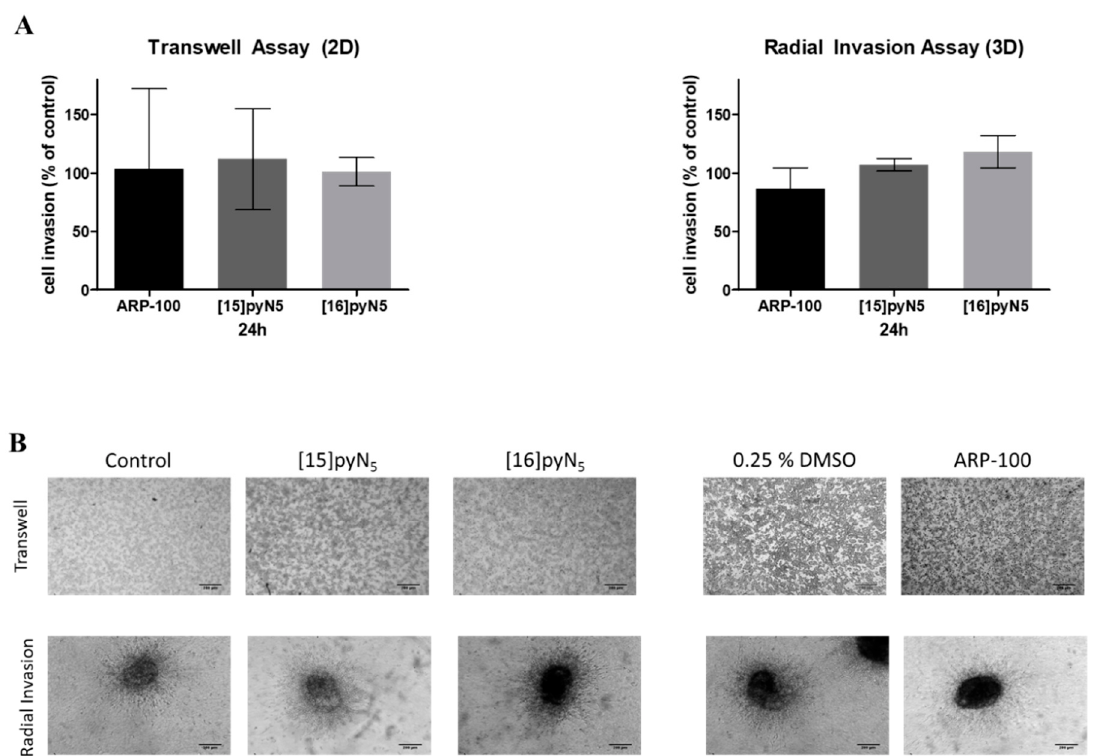
Figure 9. E ff ect of [15]pyN 5 , [16]pyN 5 and ARP-100 in cell invasion in 2D (Matrigel TM coated transwells) and 3D (radial invasion) models. ( A ) Quantification of MDA-MB-231 cell invasion after 24 h in 2D and 3D cultures. Data expressed as percentage (mean ± SD, n = 3–4) relative to controls (non-treated condition for [15]pyN 5 and [16]pyN 5 and 0.25% DMSO for ARP-100); ( B ) representative images of transwell assays and of radial invasion assays after 24 h upon incubation with 20 µ M of each compound and respective controls. Magnification 4×, scale bars = 200 µm.